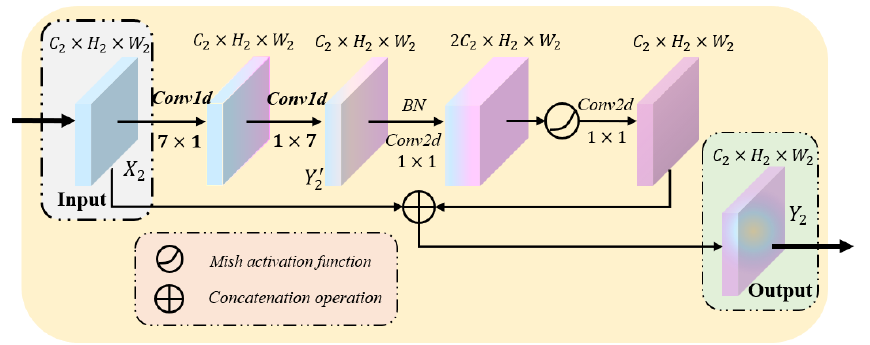
Figure 4. The specific structure of the backbone module, where BN denotes the batch normalization